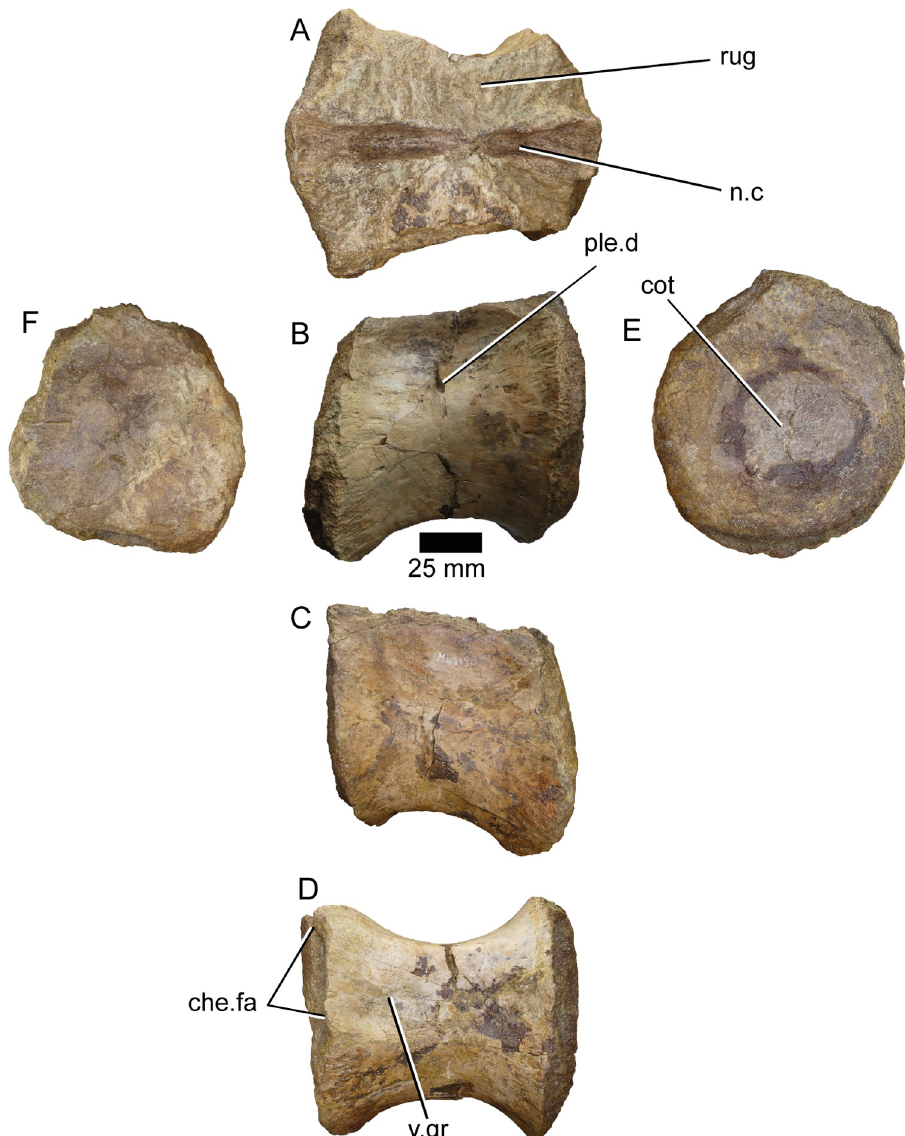
Fig 15. Caudal vertebra of Iberospinus natarioi (ML1190-15). A , dorsal, B, C; lateral, D , ventral, E , anterior, and F, posterior view. che.fa , chevron facets, cot , cotyle, n.c , neural canal, ple.d , pleurocelic depression, rug , rugosities, v.gr , ventral